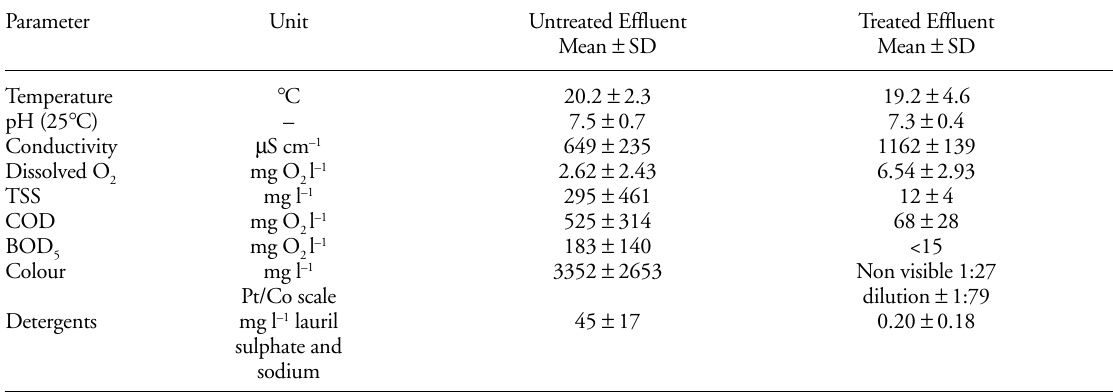
Table 1. Basic characteristics of tested effluents (TSS – Total Suspended Solids; COD – Chemical Oxygen Demand; BOD Biochemical Oxygen Demand).